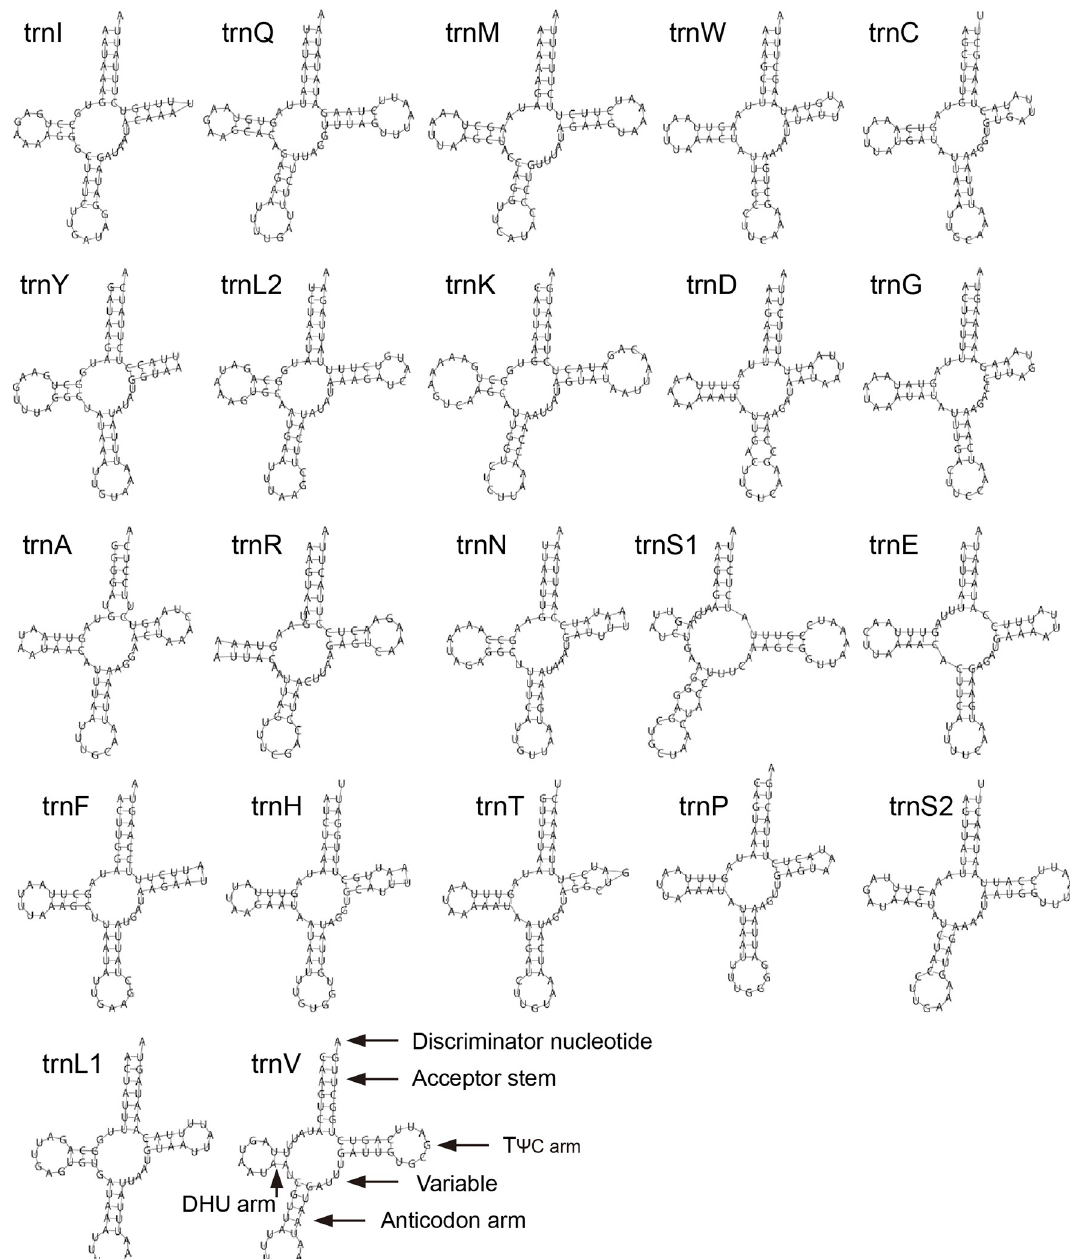
Fig 4. Predicted secondary structure of 22 tRNAs of N . montanus